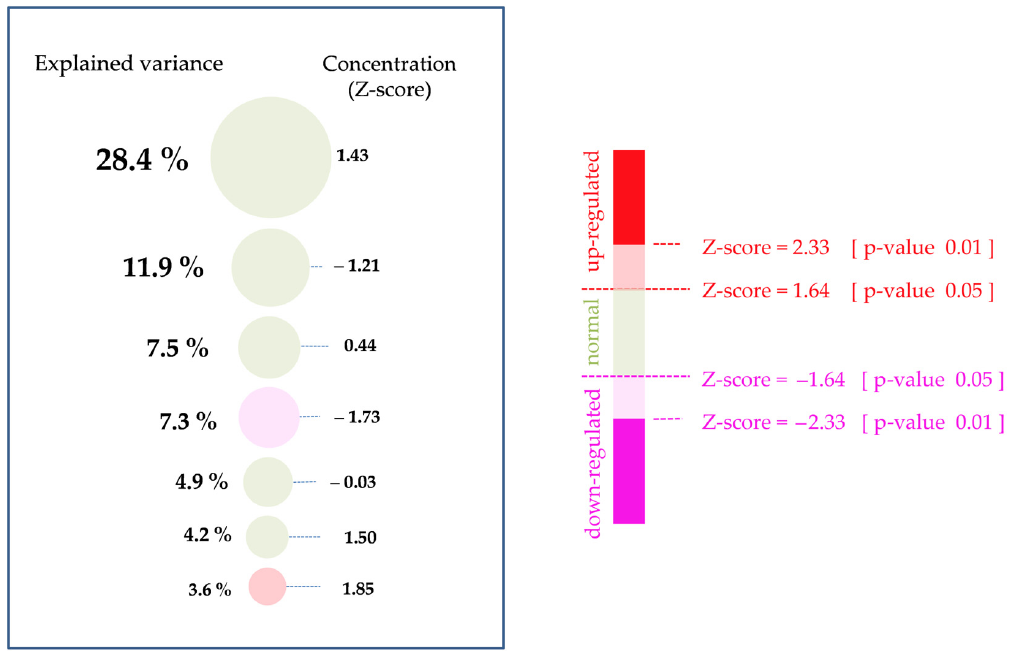
Figure 4. Mass spectrometric blood metabogram. The percentage shows the variance explained by each metabogram component. Gender, age, and biological rhythms (for example, circadian rhythm) contributing to metabolome variability are not included (only men of the same age in the study cohort). The Z-score value is a measure of the metabogram component (from − 1.64 to +1.64 is the normal range). ‘Up-’ and ‘down-regulation’ correspond to higher and lower Z-score values, respec- tively.